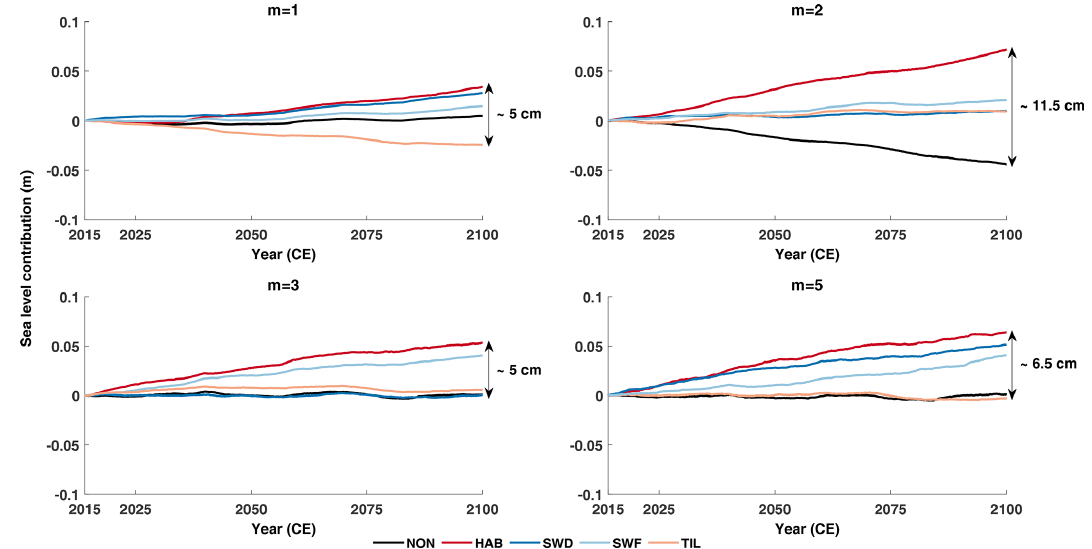
Figure 7. Sea level contribution from the Antarctic ice sheet until 2100 following NorESM1 in the RCP8.5 scenario. Each graph gives the results for one exponent of the basal sliding law, and line colours represent the different subglacial models (Table